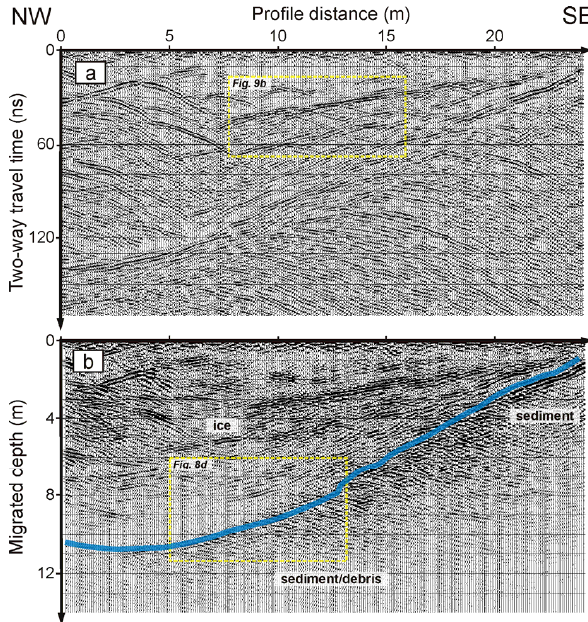
Figure 7: Radargram section (a) from Beilsteineishöhle. The blue line in the migrated section (b) shows the interpreted base. In the right part pronounced internal reflections represent both tilted layers and individual reflection hyperbolae. The inclination of the reflection bands varies between almost horizontal and the slope of the interpreted base topography.